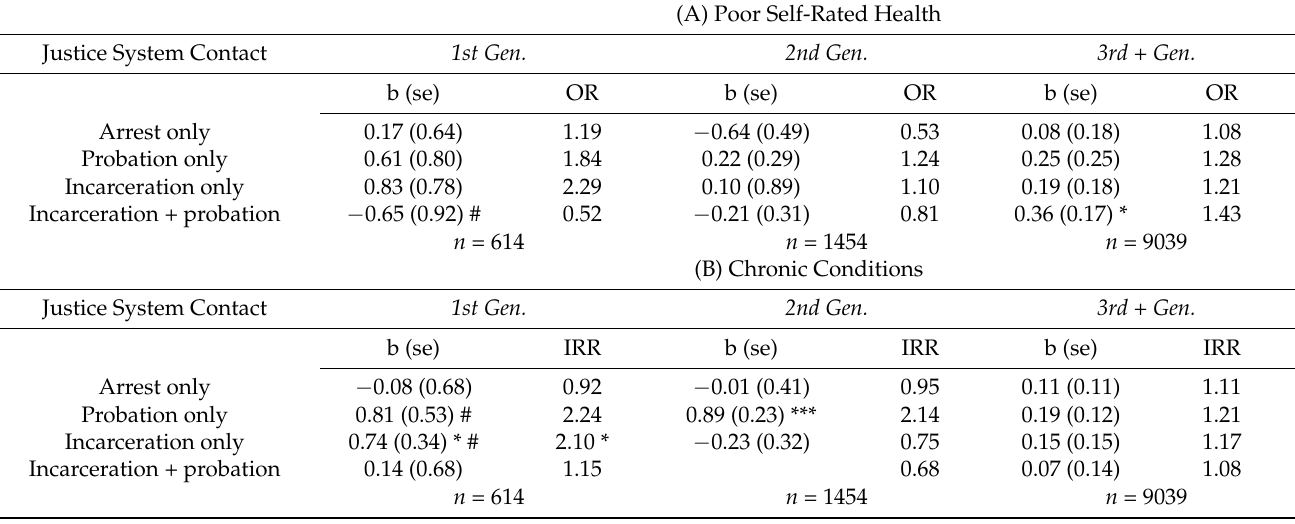
Table 3. Ordinal and Poisson regression models examining justice system contact on health by immigrant generation among U.S. adults in Wave IV of the National Longitudinal Study of Adolescent